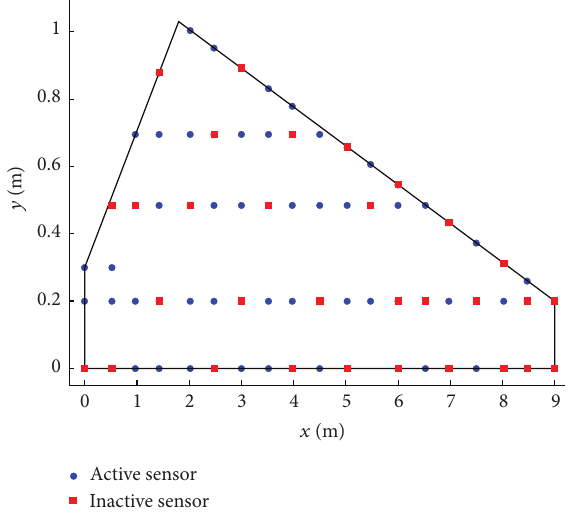
Figure 10: Sparse sensor network under